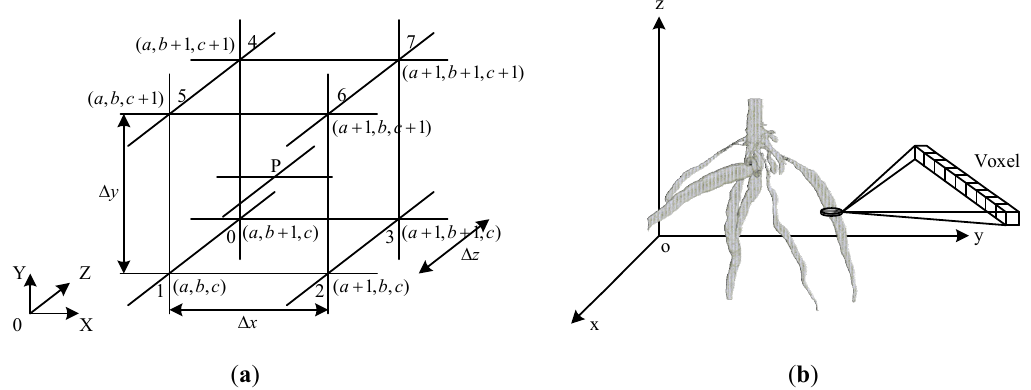
Figure 12. Smallest unit of data in three-dimensional space: ( a ) Voxel model; ( b ) Tomographic slice voxel sequence.